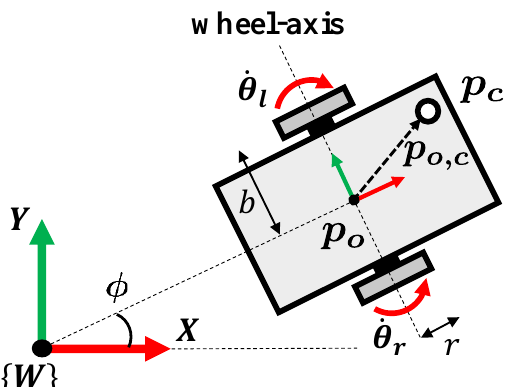
Figure 4. Schematic drawing of the differentially driven mobile robot. p c is the control point of the mobile robot in the world frame { W } and p o , c is the planar vector from the center of the mobile robot, p o , to p c in { W } . b and r are the distance between the wheel and center of the mobile robot and the radius of the wheel, respectively. ˙ θ r and ˙ θ l are the spinning velocities of the right and left wheel,